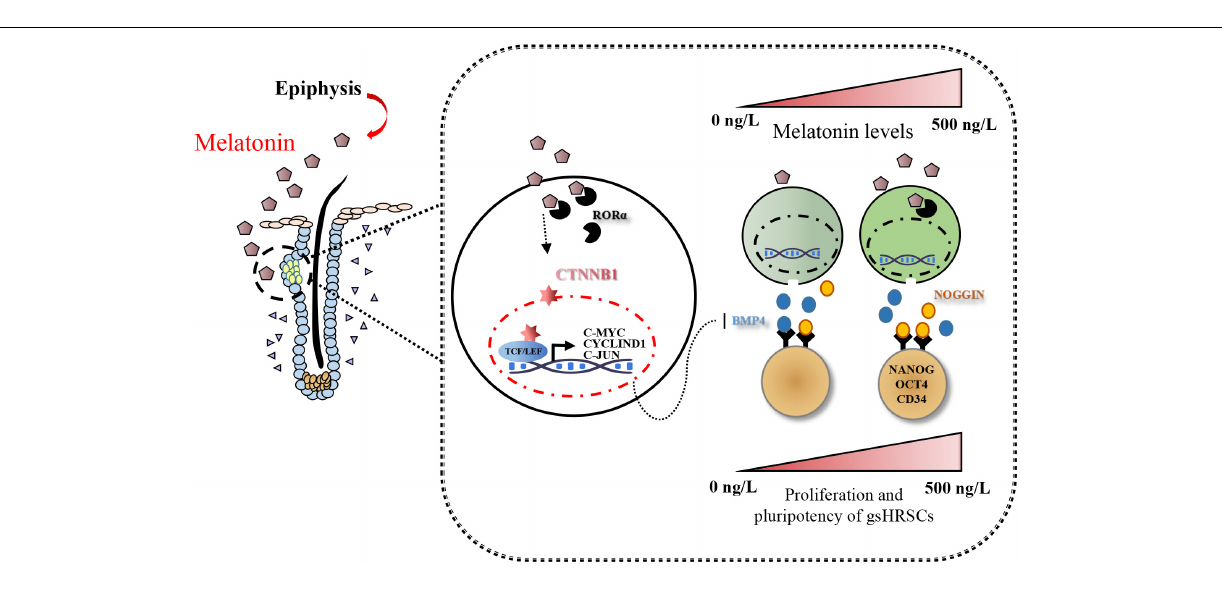
FIGURE 7 | Model summarizing the main findings of this